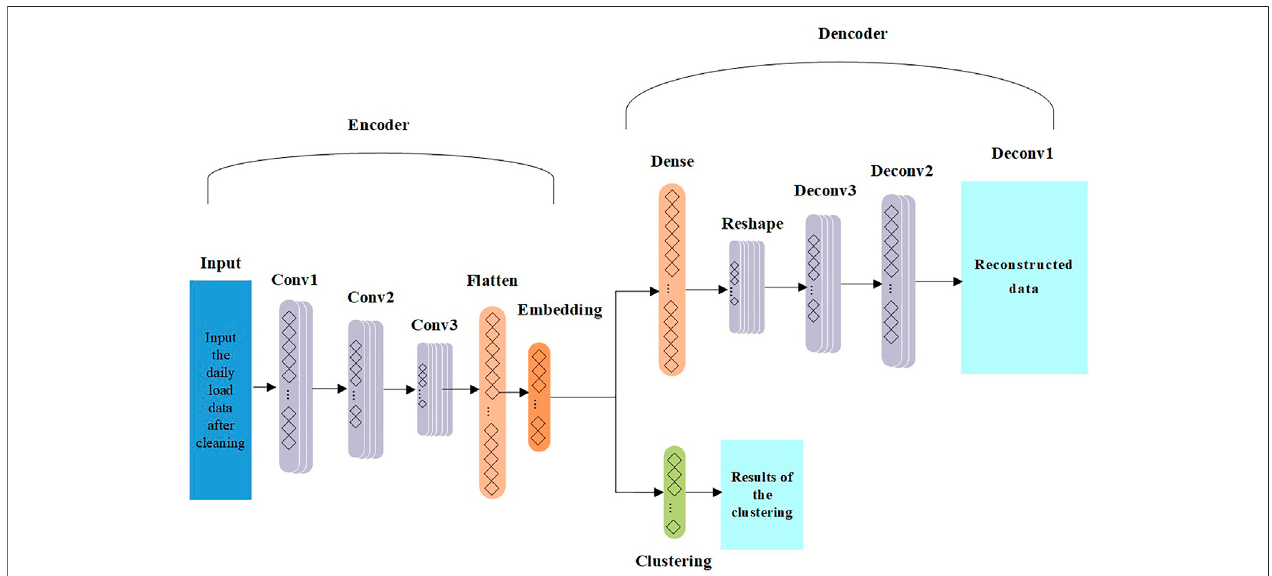
FIGURE 1 | DCEC-1D overall network